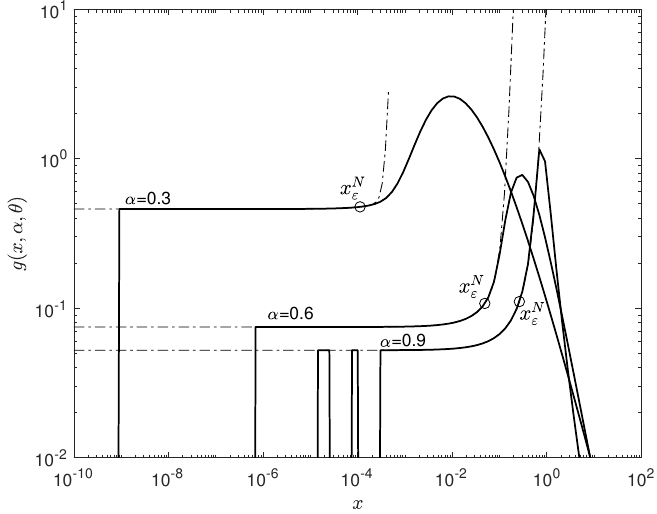
Figure 8. Probability density in the case α < 1. Solid curves are Formula (3), dash-dotted curves are the representation of (11) for N = 10, circles are the position of the threshold coordinate x N ε (36) that was used while calculating ε = 10 − 5 . Calculations are given for the specified values of α and θ = 0.9.